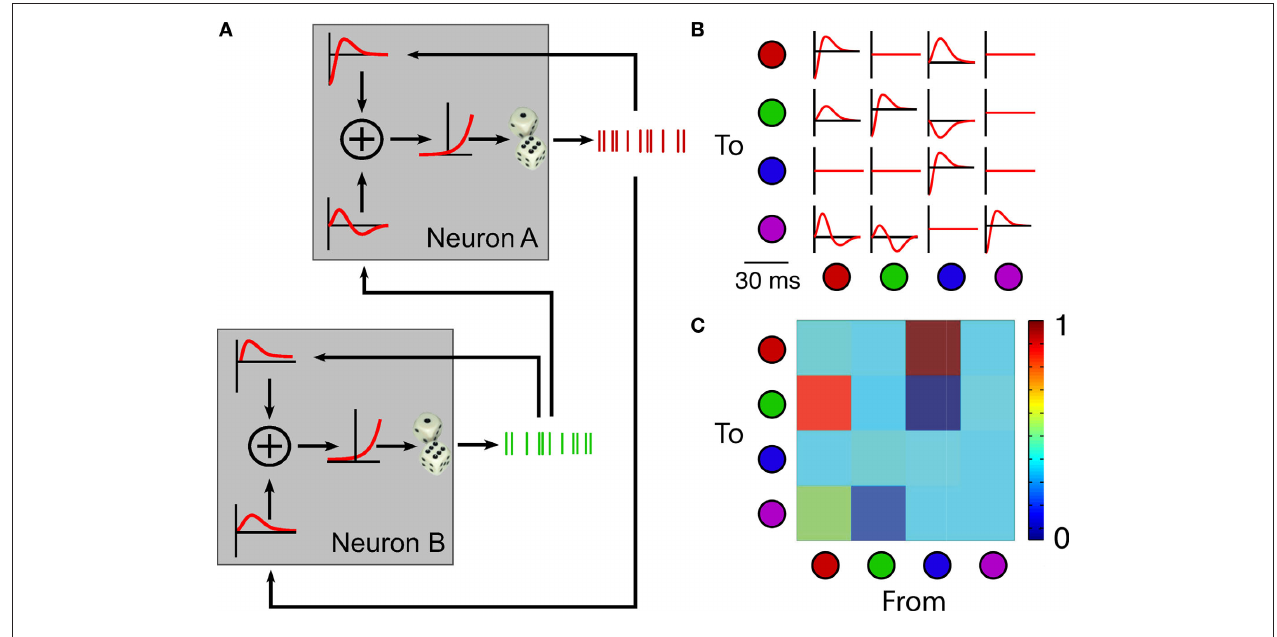
Figure 1 | Schematic diagram of the inferred functional connectivity (iFC) algorithm. (A) The discharge of each neuron is driven by input spike trains from itself and from the other neuron, each convolved with a temporal kernel. The convolved inputs are summed, a static non- linearity transforms them into firing rates, and spikes are generated from